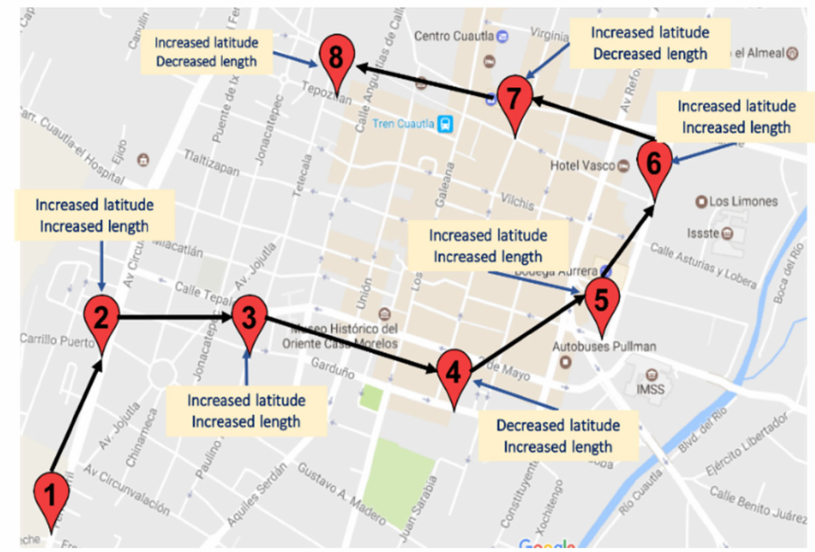
Figure 4. Example of variability of